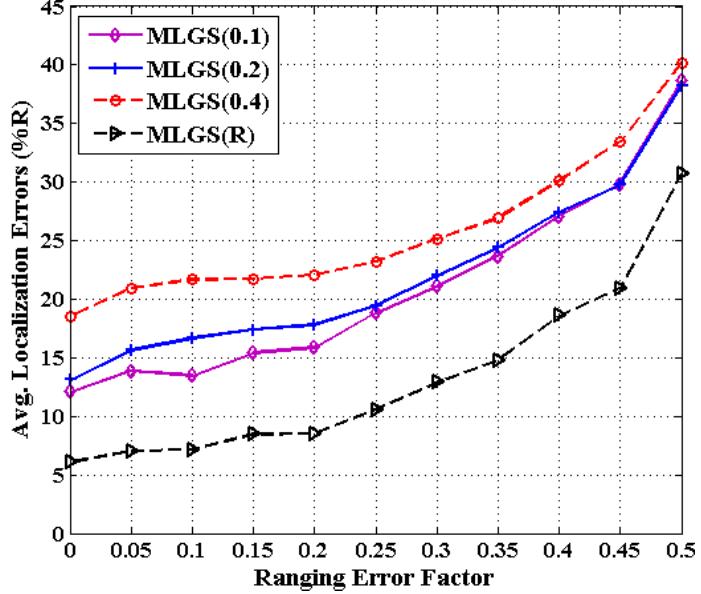
Figure 18. Average localization error versus grid granularity (isotropic network).